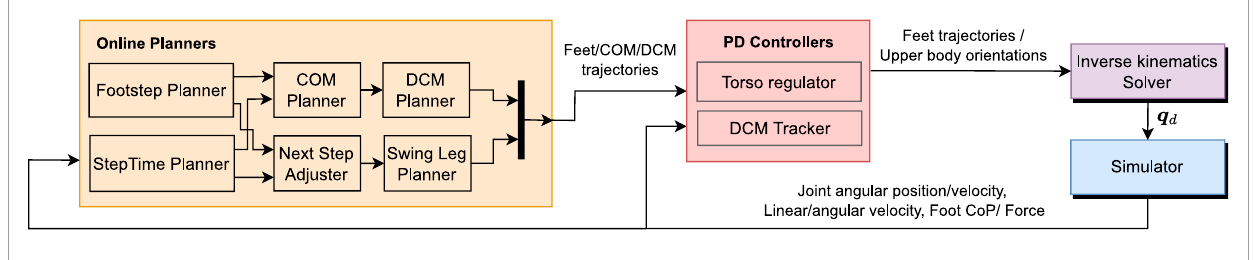
FIGURE 2 Overview of the proposed kernel gait generator. The online planners module generates a set of reference trajectories according to the input command and the states of the system. The PD controllers module is responsible for tracking the generated trajectories.